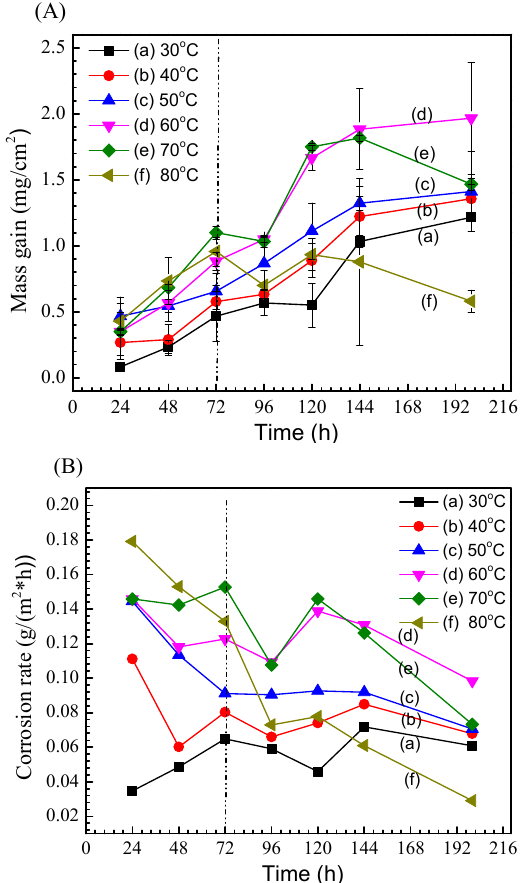
Figure 3. ( A ) Mass gain versus exposure time for 2A02 Al alloy exposed under 4 ± 0.2 mg/cm 2 solid NaCl deposit in 98 ± 2% humidity at (a) 30,(b) 40, (c) 50, (d) 60, (e) 70, and (f) 80 °C; ( B ) Corrosion rate versus exposure time for 2A02 Al alloy exposed under 4 ± 0.2 mg/cm 2 solid NaCl deposit in 98 ± 2% humidity at (a) 30,(b) 40, (c) 50, (d) 60, (e) 70, and (f) 80 °C.